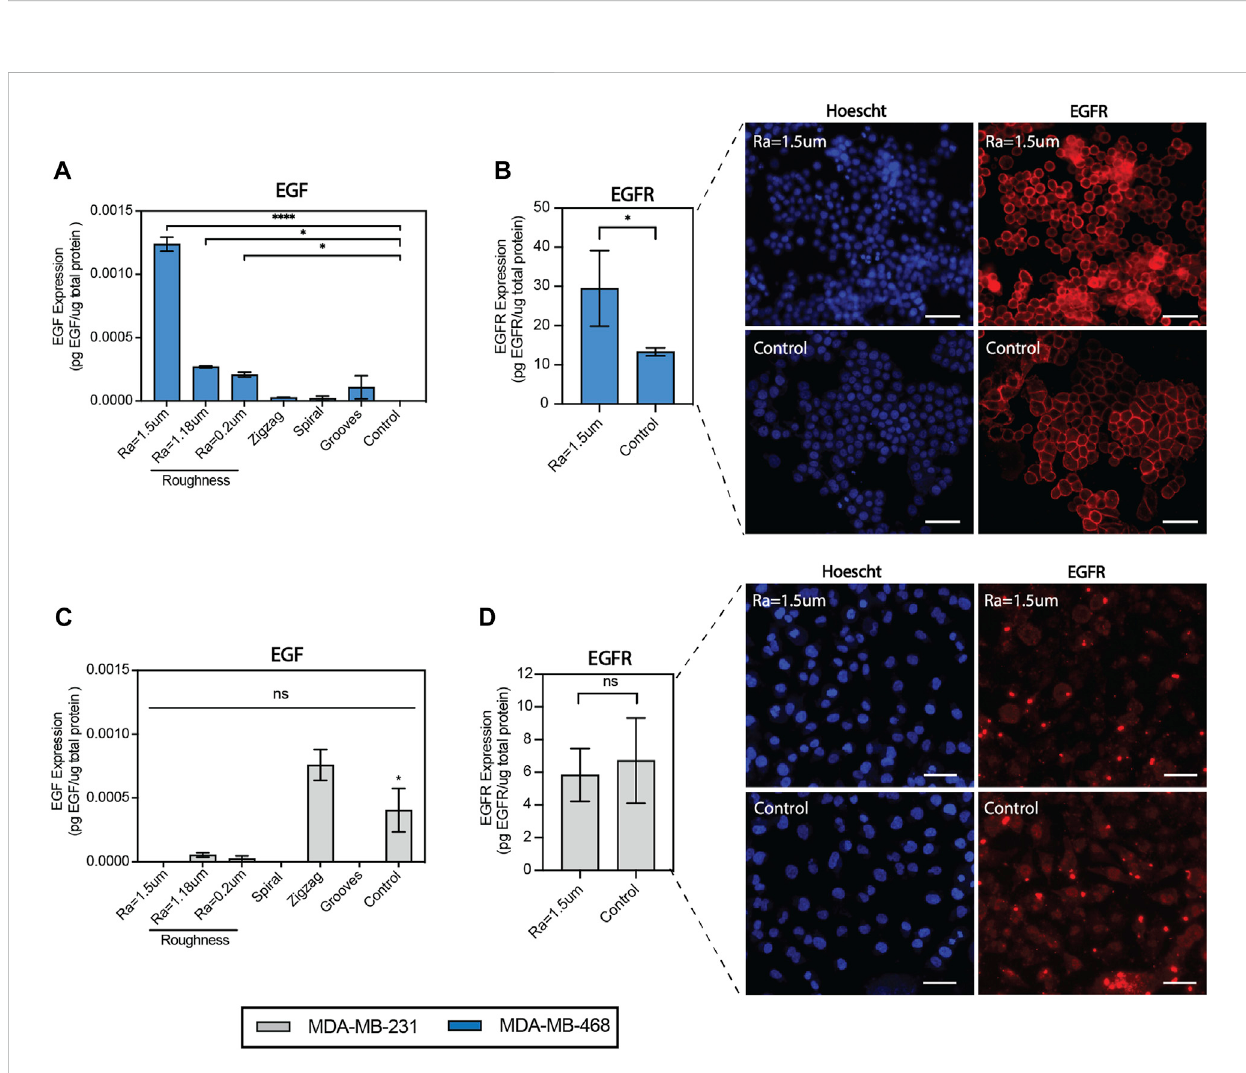
FIGURE 4 Surface roughness enhances EGF secretion and EGFR expression in MDA-MB-468 cells. (A) Quanti fi cation of epidermal growth factor (EGF) expression in MDA-MB-468 cultured on the topographical surfaces by enzyme-linked immunosorbent assays (ELISA). (B) Quanti fi cation of epidermal growth factor receptor (EGFR) expression in MDA-MB-468 cultured on surfaces with roughness Ra = 1.5 µm by enzyme-linked immunosorbent assays (ELISA),alongwithrepresentativeimagesofcellsstainedwithanti-EGFR(red)andHoechst(blue).Scalebar=50 µm. (C) Quanti fi cationofepidermal growth factor (EGF) expression in MDA-MB-231 cultured on the topographical surfaces by enzyme-linked immunosorbent assays (ELISA). (D) Quanti fi cation of epidermal growth factor receptor (EGFR) expression in MDA-MB-231 cultured on surfaces with roughness Ra = 1.5 µm by enzyme- linked immunosorbent assays (ELISA), alongwith representative images of cells werestained with anti-EGFR (red) and Hoechst (blue). Scale bar =50 µm. Error bars depict the mean ± SEM of 2 independent experiments with n = 2-3 samples. T -test with Mann-Whitney non-parametric test. Asterisk (*) represent p -values < 0.05, (**) p -values < 0.01, (***) p -values < 0.001 and (****) p -values <